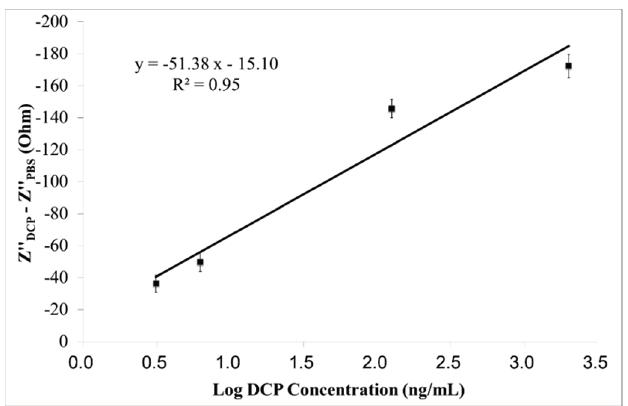
Figure 7. Linear calibration curve (Z" DCP − Z" PBS vs. Log DCP concentration) of the immunosensor on measuring DCP (3.125–2000 ng/mL) at the optimum measuring frequency of 23.870 kHz, within the specific frequency range (21.080–39.244 kHz). Results are expressed in mean ± SD (n =